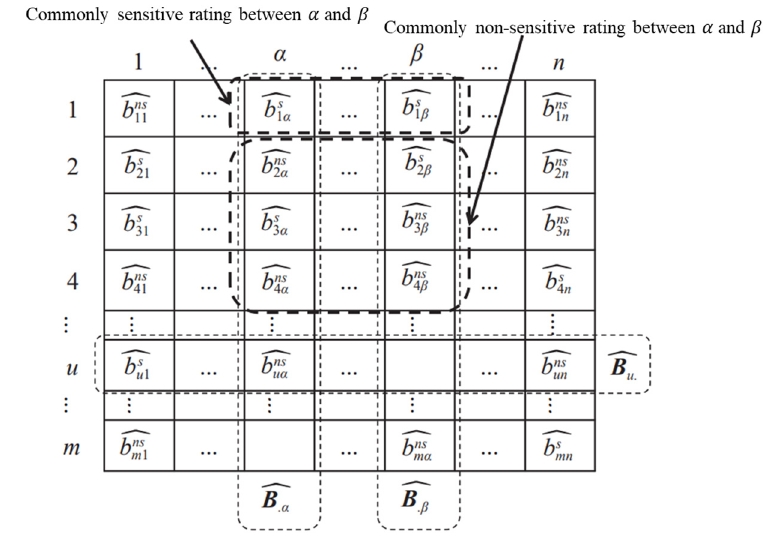
Figure 3. Perturbation matrix 𝐵(cid:3552) .